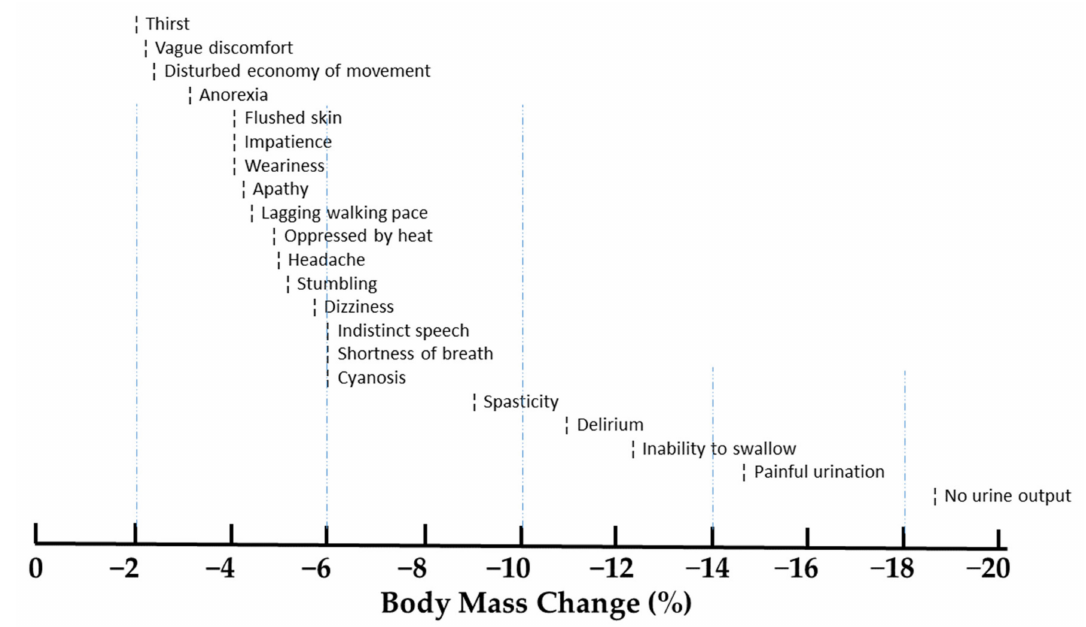
Figure 1. Signs and symptoms of dehydration in men who walked in the desert without drinking. The symbol which appears to the left of each sign or symptom identifies the approximate water deficit of its first report. Based on information from